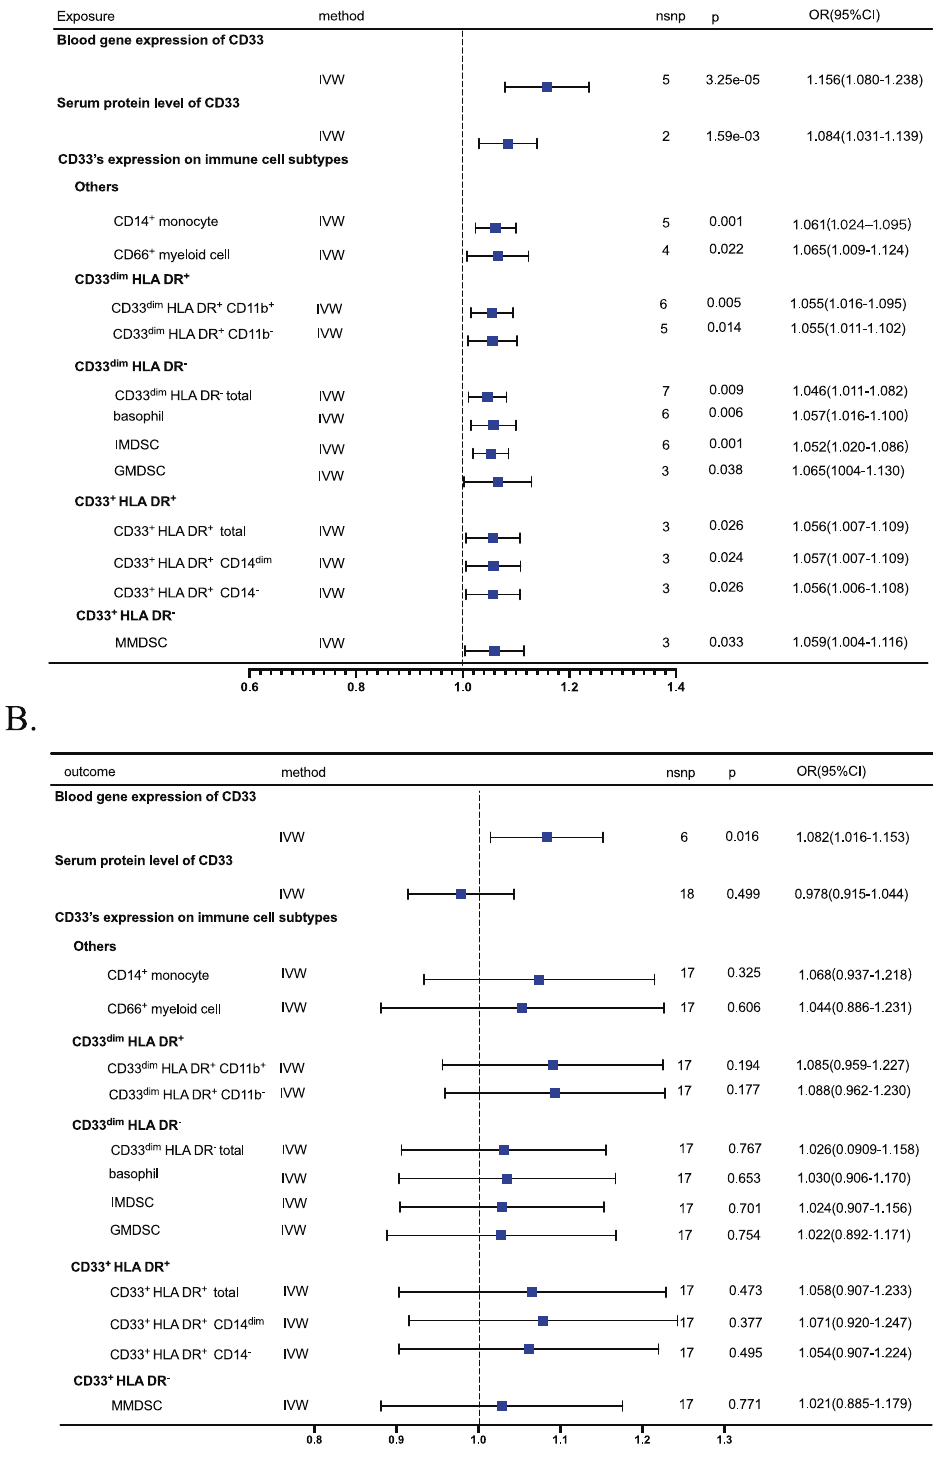
Fig. 2 Forest plot for the IVW results of bidirectional 2-sample MR analyses. A AD as the outcome, and CD33 traits as exposure, forest plot showing the causal effect of CD33 on AD; B AD as exposure, and CD33 traits as the outcome, forest plot showing the causal effect of AD on